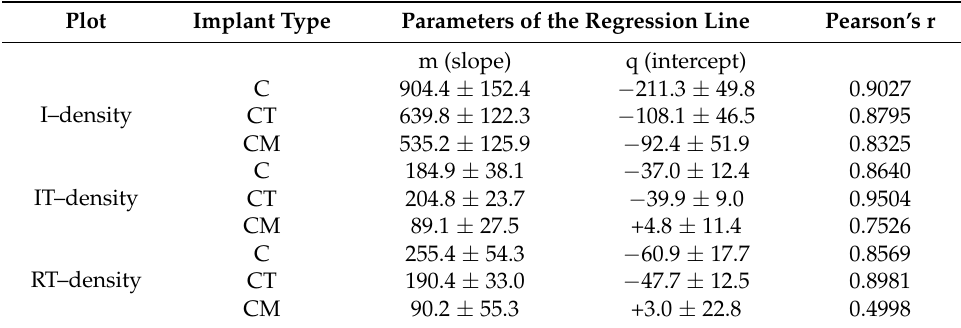
Table 3. Parameters of the y = mx + q lines best fitting the I–density, IT–density, and RT–density plots and corresponding Pearson’s r regression coefficients. C, cylindrical; CT, cylindrical-tapered; CM, cylindrical-modified, D, density.